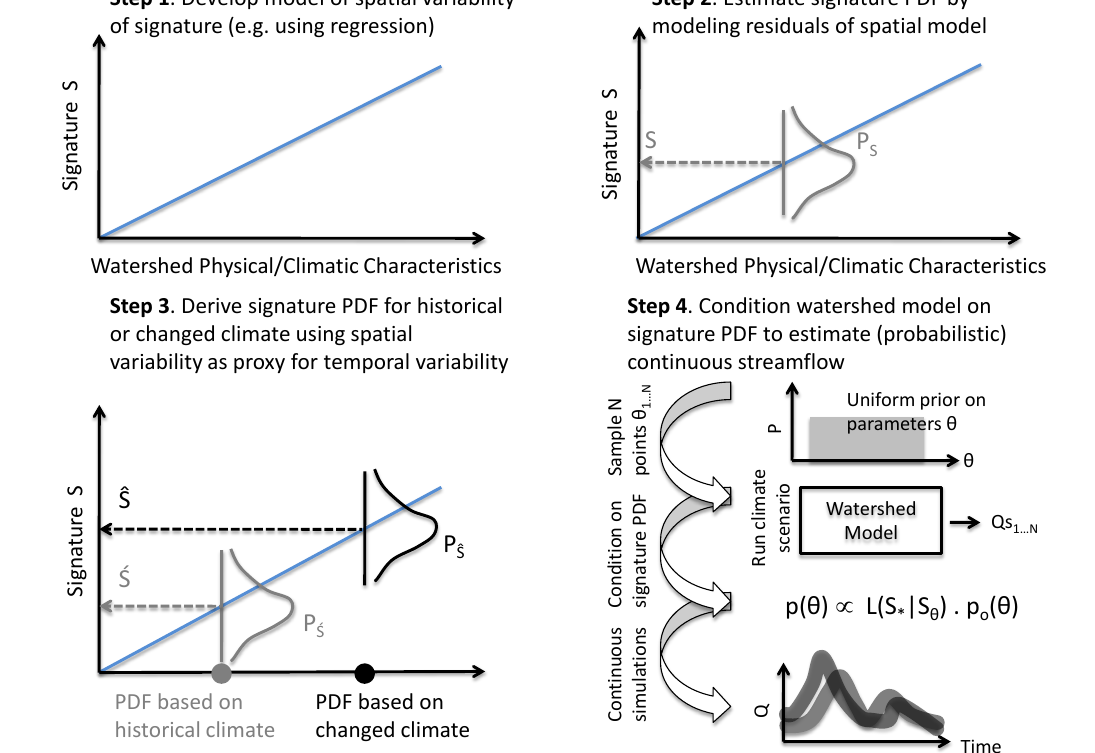
Fig. 1. The four step procedure for deriving probability distributions of streamflow for climate scenarios. In Step 2, S a signature and P S is the probability associated with a signature value. In Step 3, ´ S and P ´ correspond to the distribution based on changed climate. In Step 4, θ represents the model parameters, Qs 1 ...N represents the model P ˆ S simulations, S ∗ is the expected value of the signature derived from the regionalized relationship and S θ is the value of the signature for the parameter θ